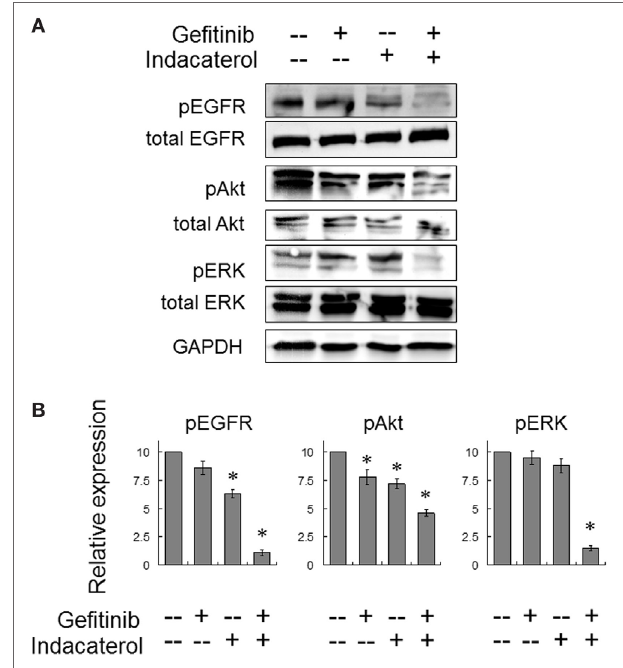
FigUre 5 | Combination of gefitinib and indacaterol giving rise to more pronounced inhibition of the epidermal growth factor receptor (EGFR)–PI3K– Akt pathway in EGFR T790M-bearing H1975 cells. (a) Cells were treated with gefitinib alone (10 µM), indacaterol alone (10 µM), or their concomitant combination for 4 h before harvest for Western analysis. A representative set of data is shown. Cropped blots from different gels are grouped together for clear illustration. The full-length gels are shown in Figure S6 in Supplementary Material. (b) Summary of the Western blot analysis from three independent experiments. Data are presented in histogram as mean ± SD. * p < 0.05, Student’s t -test, compared with no treatment control.